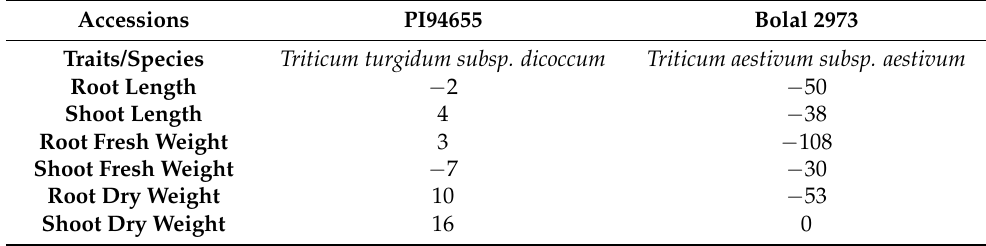
Table 2. Percentage changes in the physiological parameters of the Triticum dicoccum